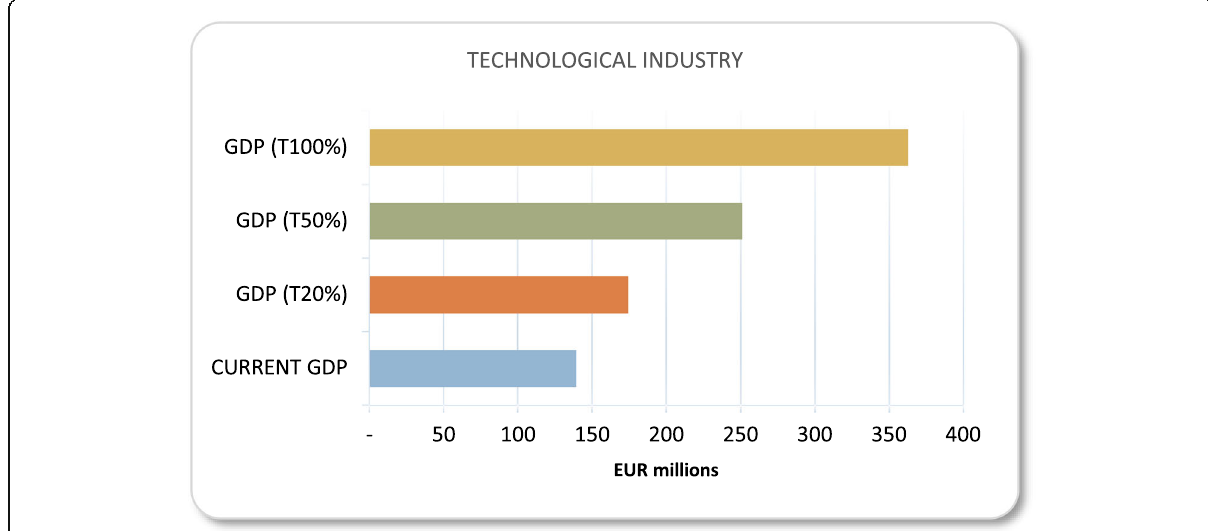
Fig. 14 GDP forecast of the Spanish technological industry